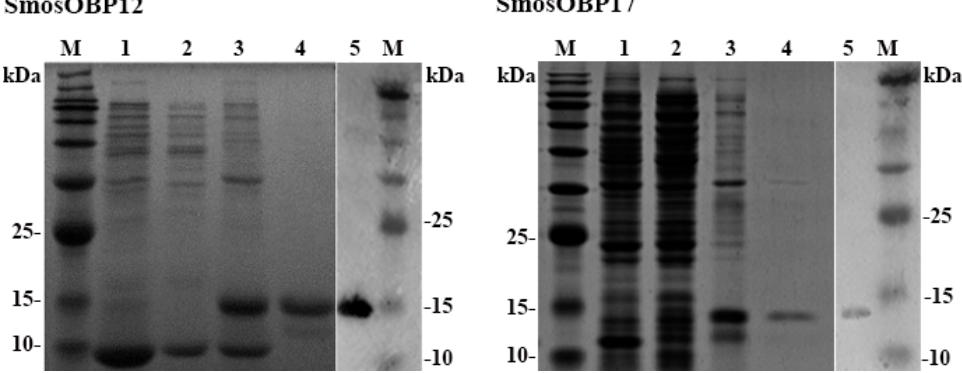
Figure 2. Bacterially expressed SmosOBP12 and SmosOBP17. SDS-PAGE of un-induced recombinant Escherichia coli harboring pET28a (+)/SmosOBPs (lane 1), supernatant (lane 2) and precipitate (lane 3) of IPTG-induced E. coli , and Ni-NTA affinity-purified SmosOBPs (lane 4). Western blot analysis of purified SmosOBPs (lane 5). M, molecular weight markers.